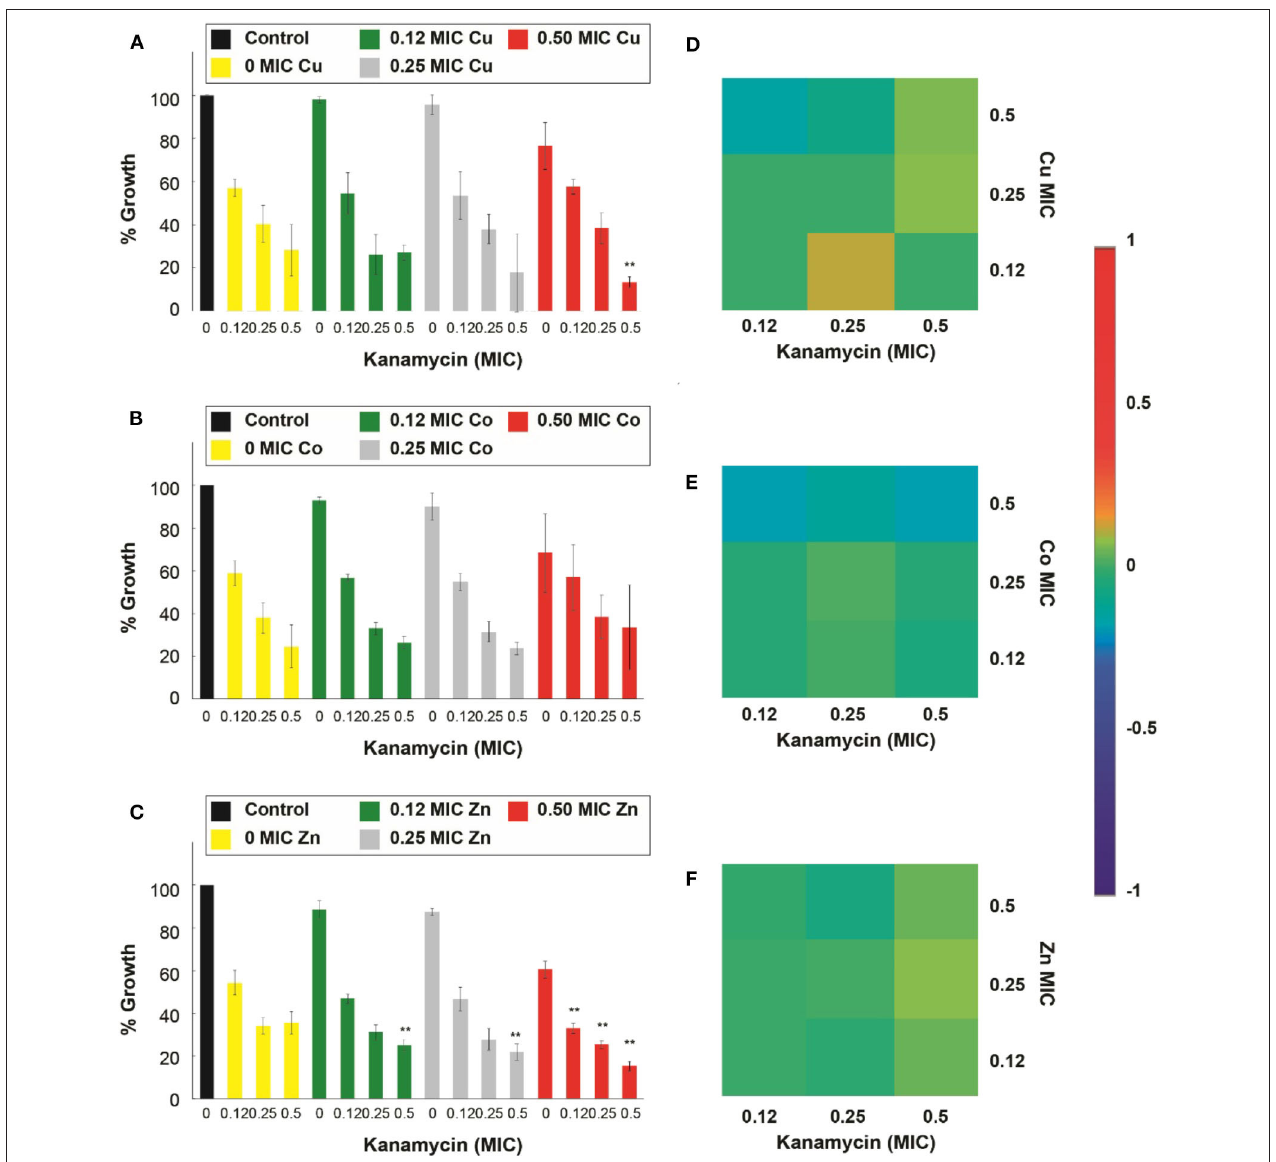
FIGURE 7 | Antimicrobial effect and interactions of ATMCs in kanamycin-resistant E. coli . Growth percentage by sub-inhibitory concentrations of metal ion-antibiotic combinations: (A) Cu 2 + -kanamycin, (B) Co 2 + -kanamycin, and (C) Zn 2 + kanamycin against E. coli-Kan . Classification of the different interactions between metal ion-antibiotic combinations. The interactions of (D) Cu 2 + -kanamycin, (E) Co 2 + -kanamycin, and (F) Zn 2 + -kanamycin combinations are classified as synergistic, additive or antagonist, value > 0, = 0, and < 0, respectively. Each experiment was done in triplicates. **Corresponds to a significant difference ( p < 0.05) concerning the control and each of the individual treatments. Error bars correspond to the standard deviation from experiments performed in triplicates.